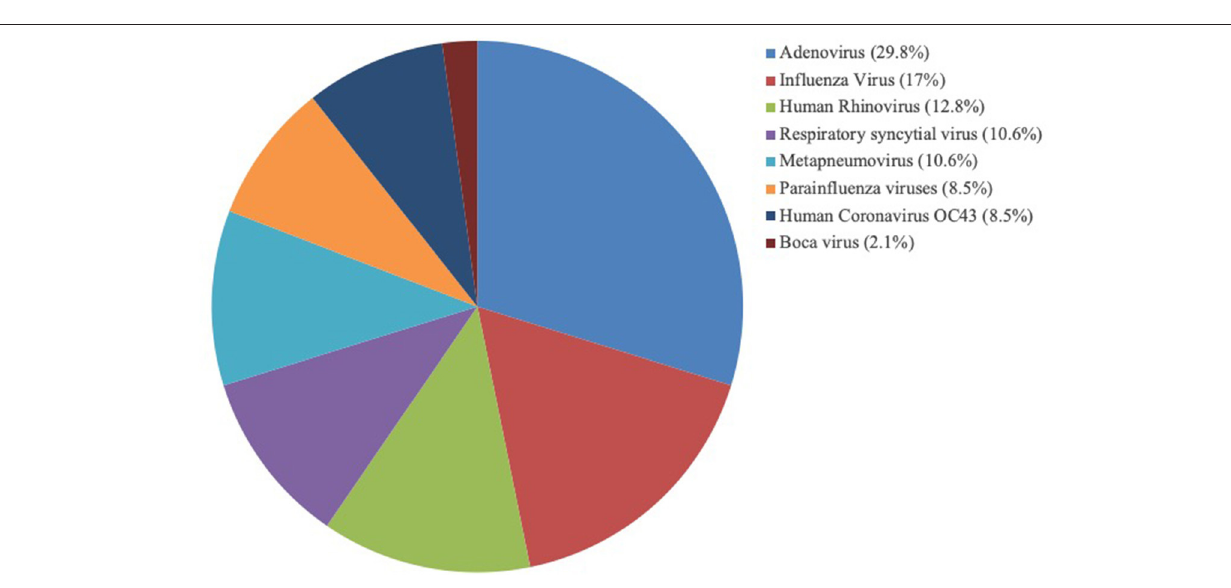
FIGURE 2 | Distribution of viruses detected in 47 ARDS